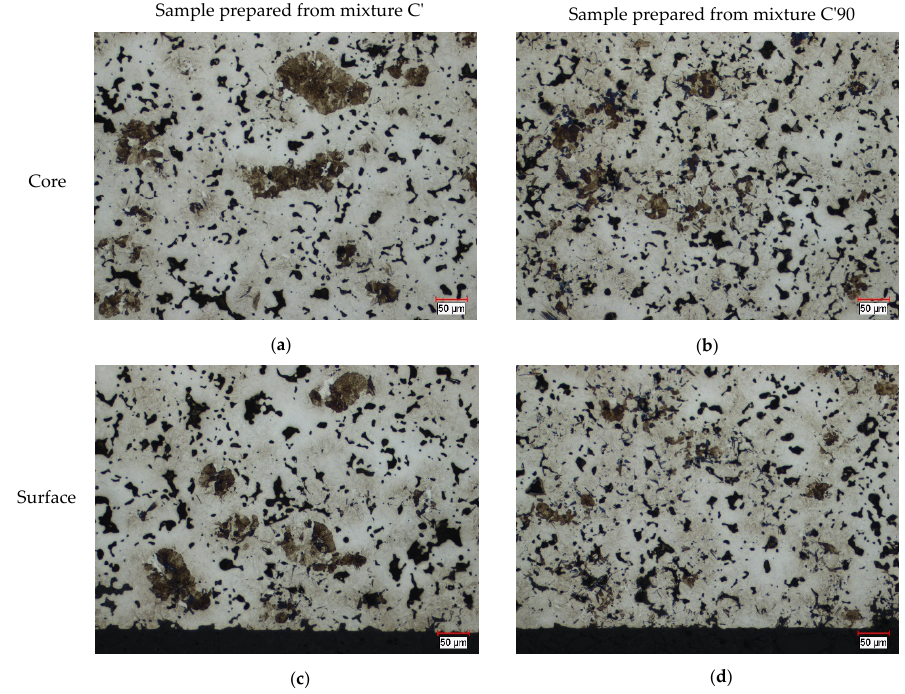
Figure 15. Optical images for sintered and heat treated bars prepared from powder mixtures C’ and C’90 using magnification 200 × , images ( a , c ) are for a sample prepared from mixture C’ at core and surface, images ( b , d ) are for a sample prepared from mixture C’90 at core and surface respectively.